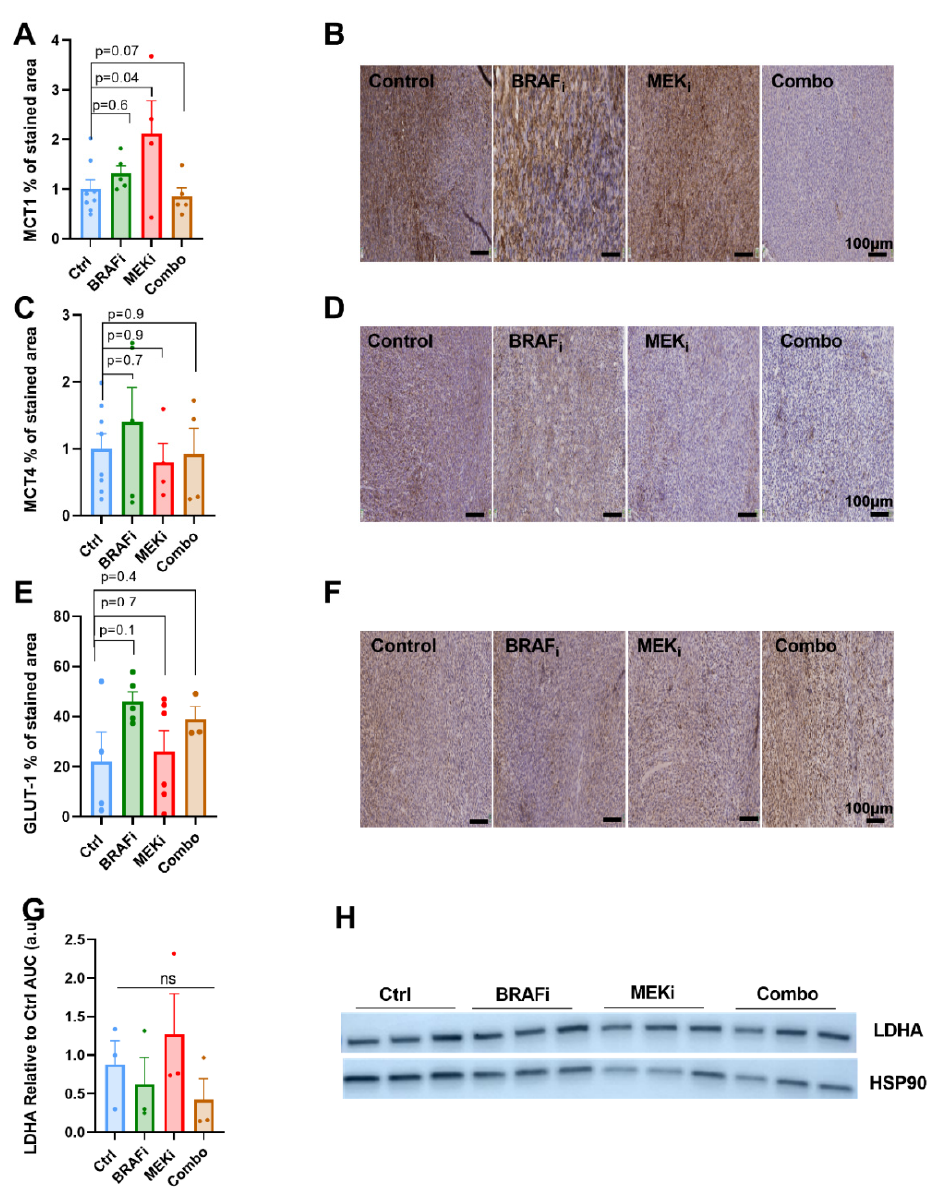
Figure 4. Expression of metabolic transporters and LDH-A in response to BRAF or MEK inhibition in YUMM1.7 xenografts. MCT1, MCT4 and GLUT-1 staining area (relative to control) from xenografts obtained 24 h after single injection of the indicated treatments All scale bars = 100 µ m. One-way anova, Holm-Sidak multiple comparisons test. Sample size: n = 8 for Ctrl and n = 5 for BRAF i , MEK i and Combo group ( A – F ). AUC analysis of LDHA. Corresponding to the ( G ) Western blot of the lactate deshydrogenase LDHA 24 h after treatments ( H